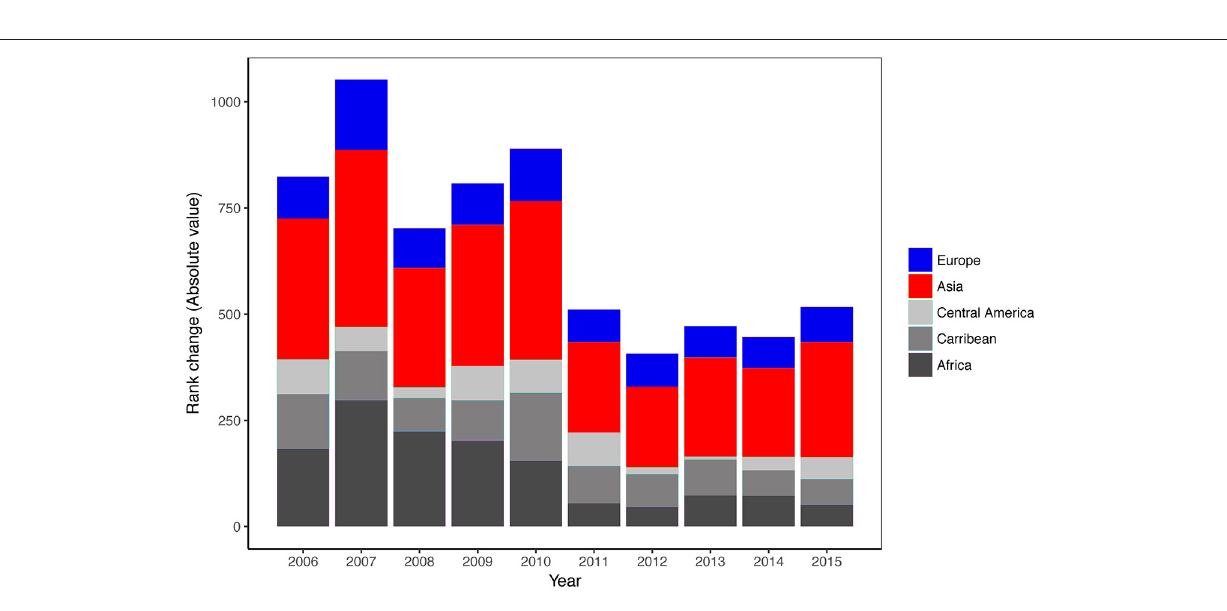
FIGURE 2 | Relative degree of masking of true market dependence by region. Values are based on total change in rank order (aggregated by region) when comparing eigenvector centrality scores based on direct, and combined direct and re-exported lobster trade statistics. Note that North America is not visible in the graph as it consistently ranks as the most important node in the network and rank does not